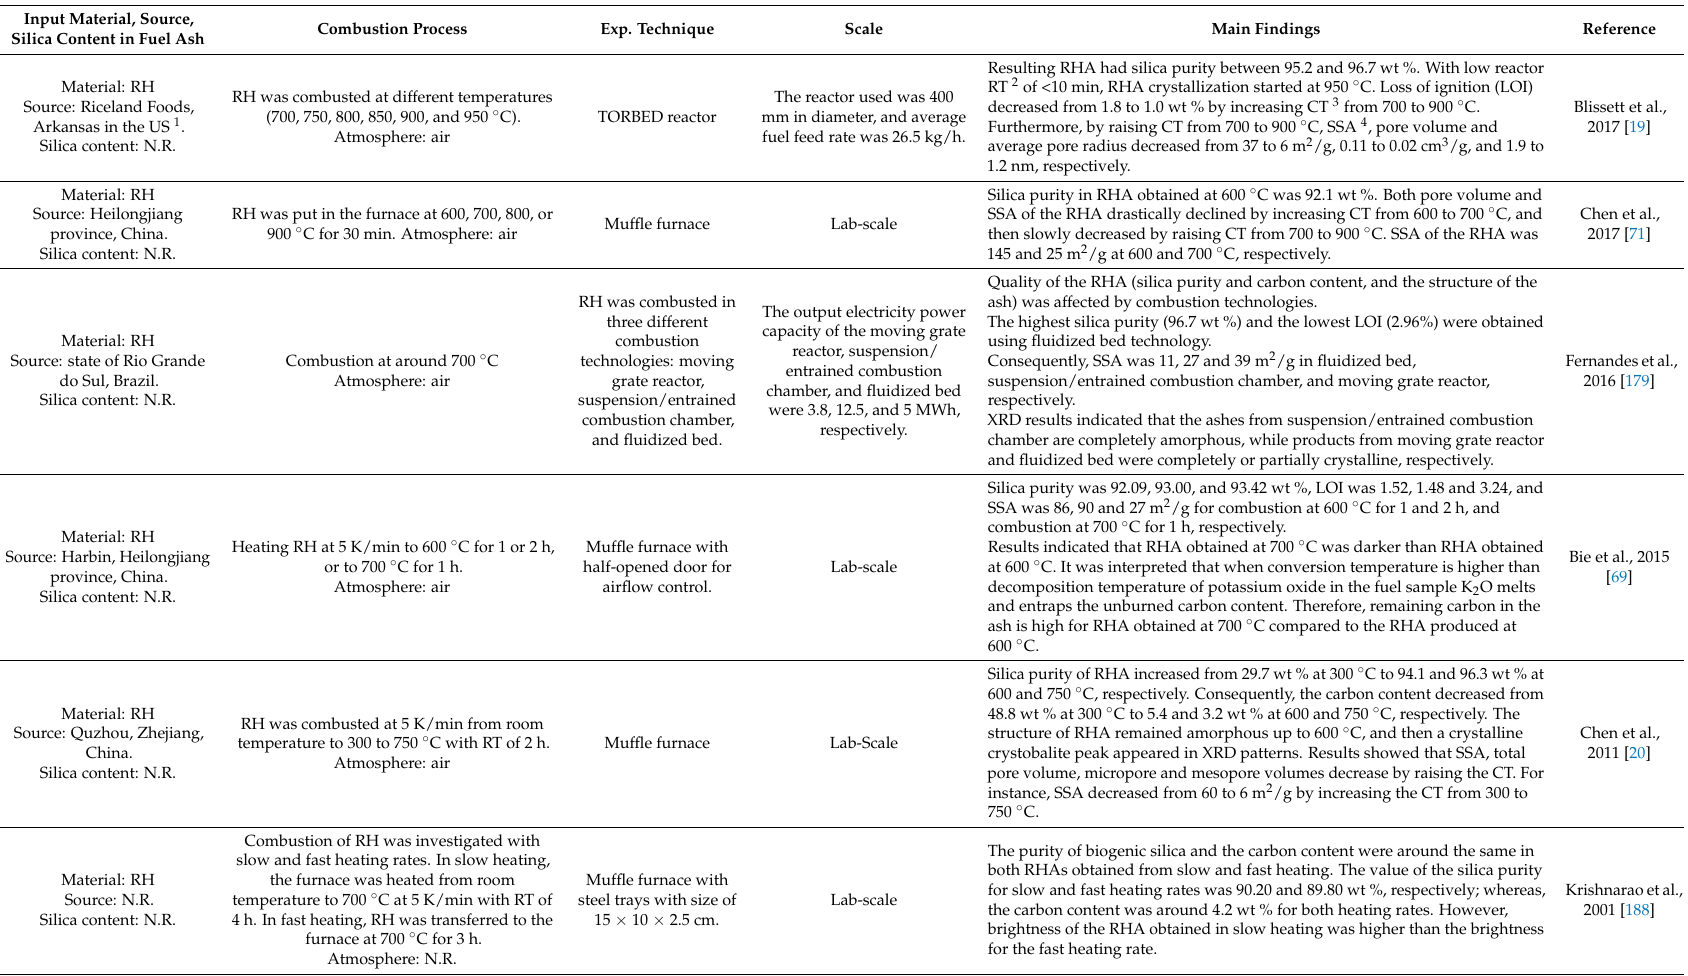
Table 3. Combustion of RH to obtain pure biogenic